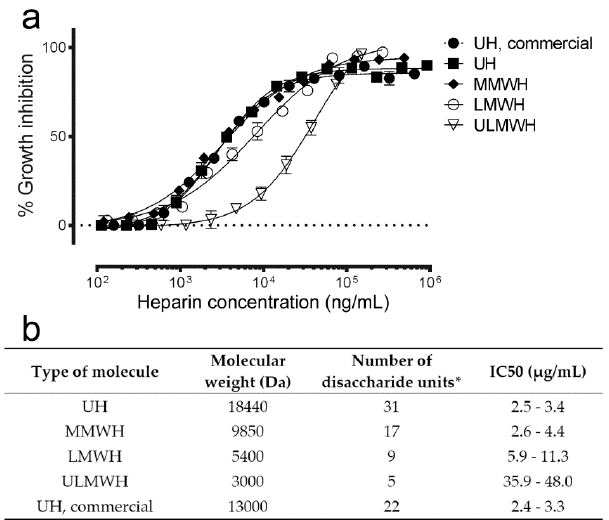
Figure 2. In vitro antimalarial activity of heparins with different molecular weight. ( a ) In vitro P. falciparum growth inhibition activity assay of heparin fractions of decreasing chain lengths. ( b ) Description of the heparin samples tested in panel ( a ). MMWH: medium molecular weight heparin,